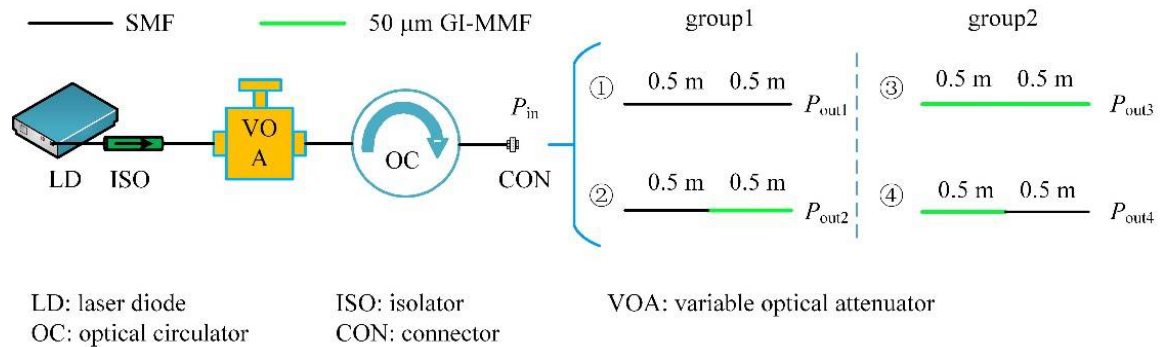
Figure 3 . Experimental setup for measuring coupling efficiency. Figure 3. Experimental setup for measuring coupling